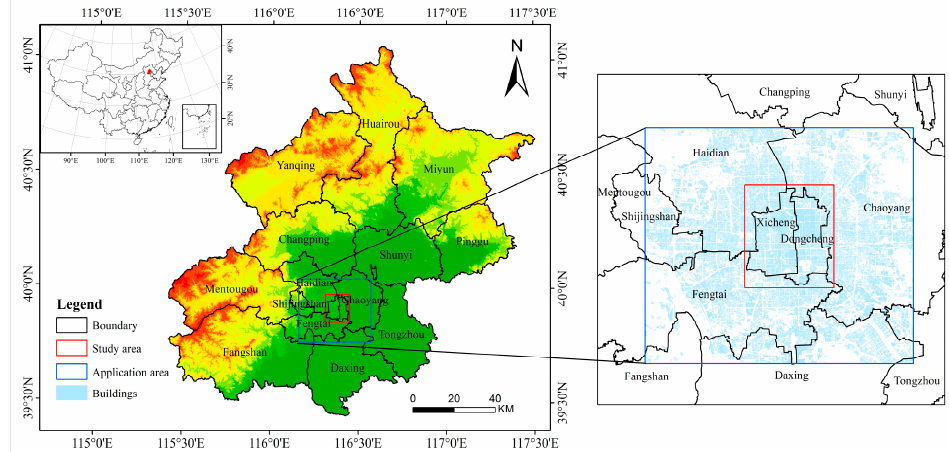
Figure 1. The study area of Beijing, China.